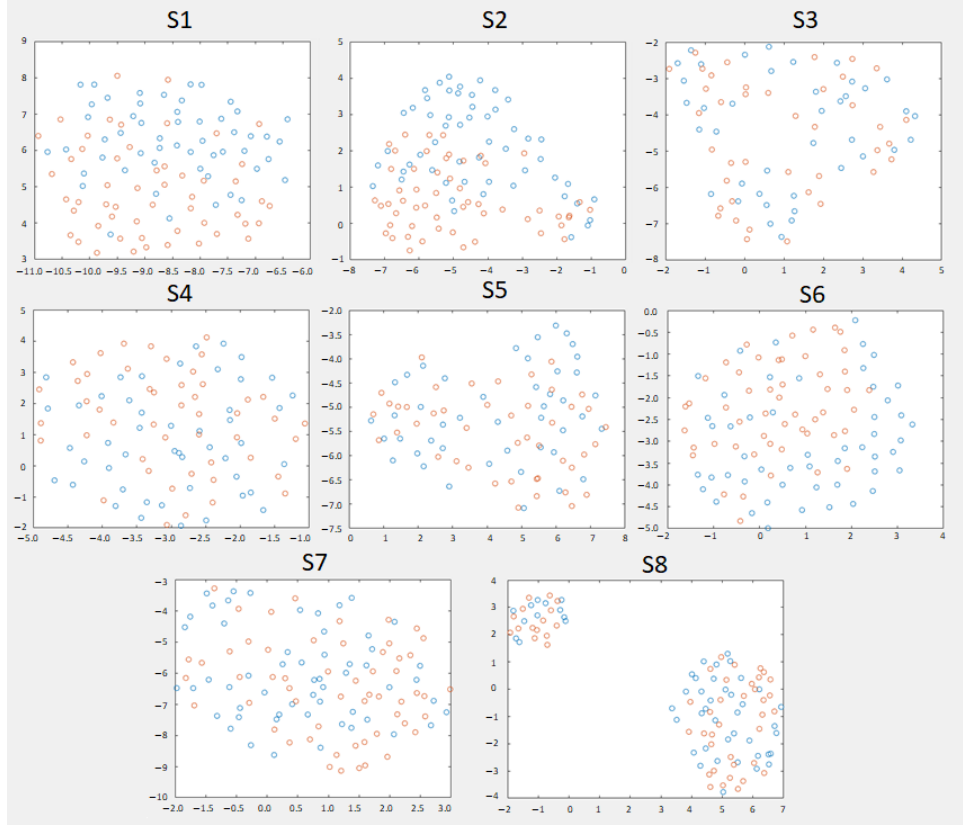
Figure 4. The 2D dimensionality Riemannian reduction in the Riemannian tangent space of eight trials chosen to make the model of each subject. The bands chosen for each model are those of the personalized configuration H ∞ . In blue, the epochs of monotonous walk and in orange the epochs of intention to change